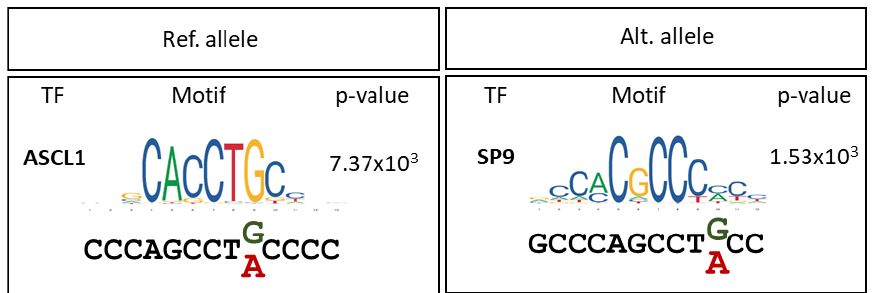
Figure 4. In silico prediction of transcription factor binding. Transcription factors with differential binding to variant c.2459+21C>T (Alt. allele) and the wild-type sequence (Ref. allele) are depicted. Binding motifs and p -values are also shown.